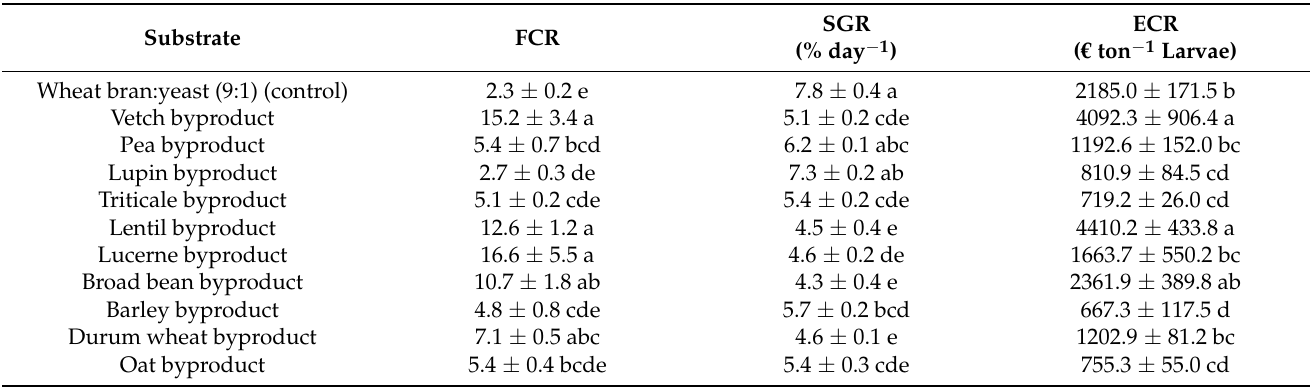
Figure 6. Development time (days) of Alphitobius diaperinus larvae reared on byproducts of the seed cleaning process of cereals and legumes or a mixture of wheat bran and yeast (9:1) (control). Bars followed by the same lowercase letter are not significantly different. In all cases, values represent means ± SEM (n = 6; df = 10; p = 0.05). Table 3. Feed conversion ratio (FCR), specific growth rate (SGR, % day − 1 ) and economic conversion ratio (ECR, € ton − 1 larvae) of Alphitobius diaperinus larvae reared on byproducts of the seed cleaning process of cereals and legumes and a mixture of wheat bran and yeast (9:1) (control) (n = 6).